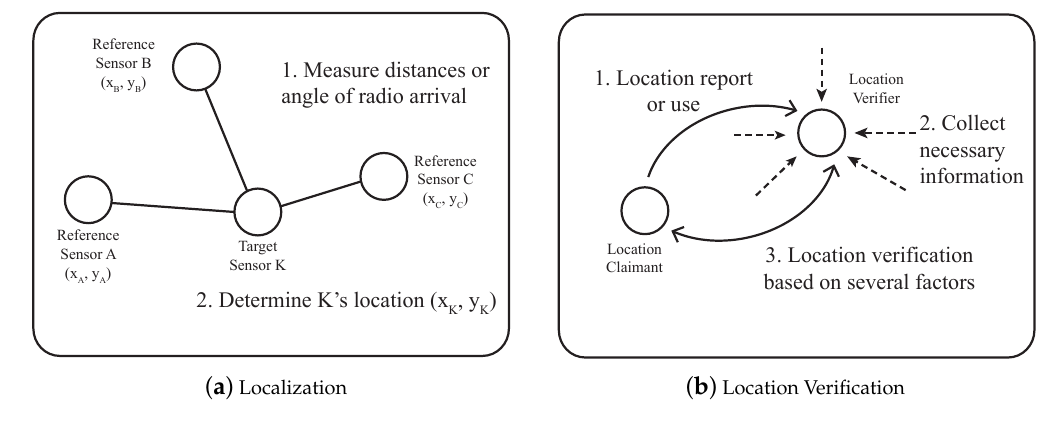
Figure 1. Localization and location